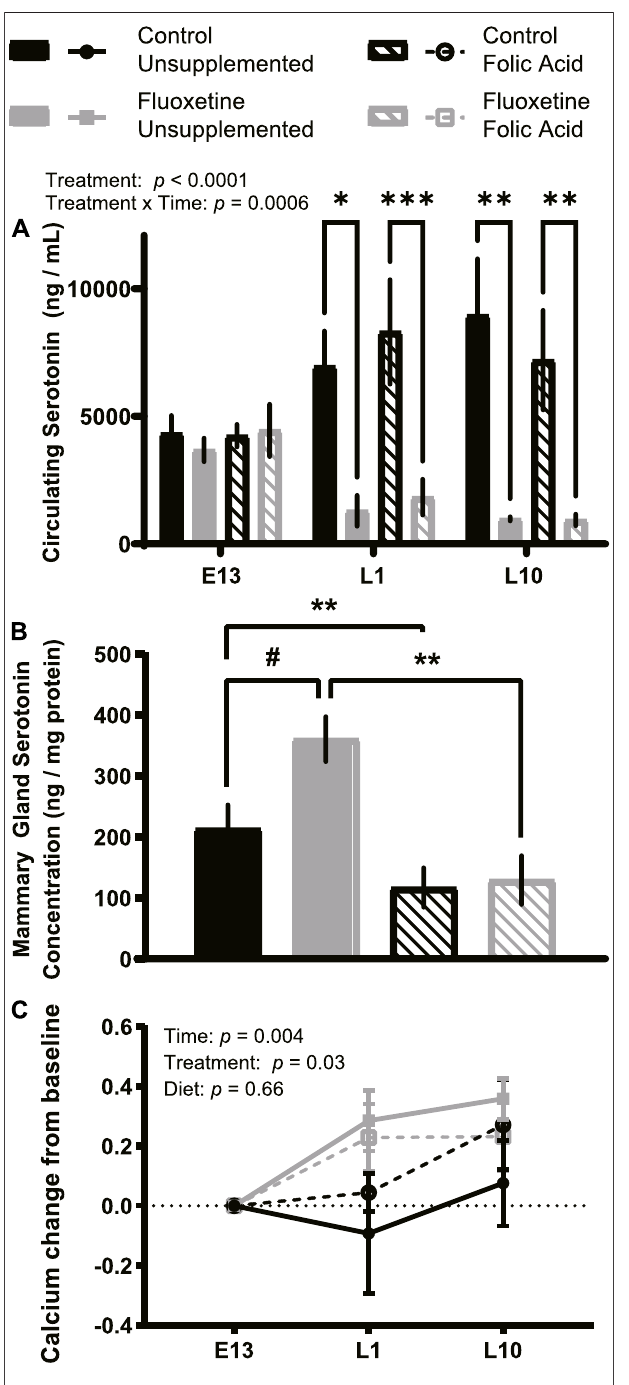
FIGURE 1 | Circulating serotonin and calcium concentrations are impacted by fl uoxetine but not folic acid (FA) supplementation. C57BL/6J mice were randomly assigned to a FA supplemented (24 mg/kg FA in diet) or breeder diet (4 mg/kg FA in diet) for 2 weeks prior to mating. On embryonic day 13 (E13), dams were randomly assigned into control (breeder diet, saline injection; n = 8), fl uoxetine (breeder diet, 20 mg/kg/d fl uoxetine injection; n = 8), FA (FA diet, saline injection; n = 8), or interaction (FA diet, 20 mg/kg/d fl uoxetine injection; n = 8) groups. Blood samples were collected fromallmiceatthestartoftreatmentonE13,lactationday1(L1),andlactation ( Continued )